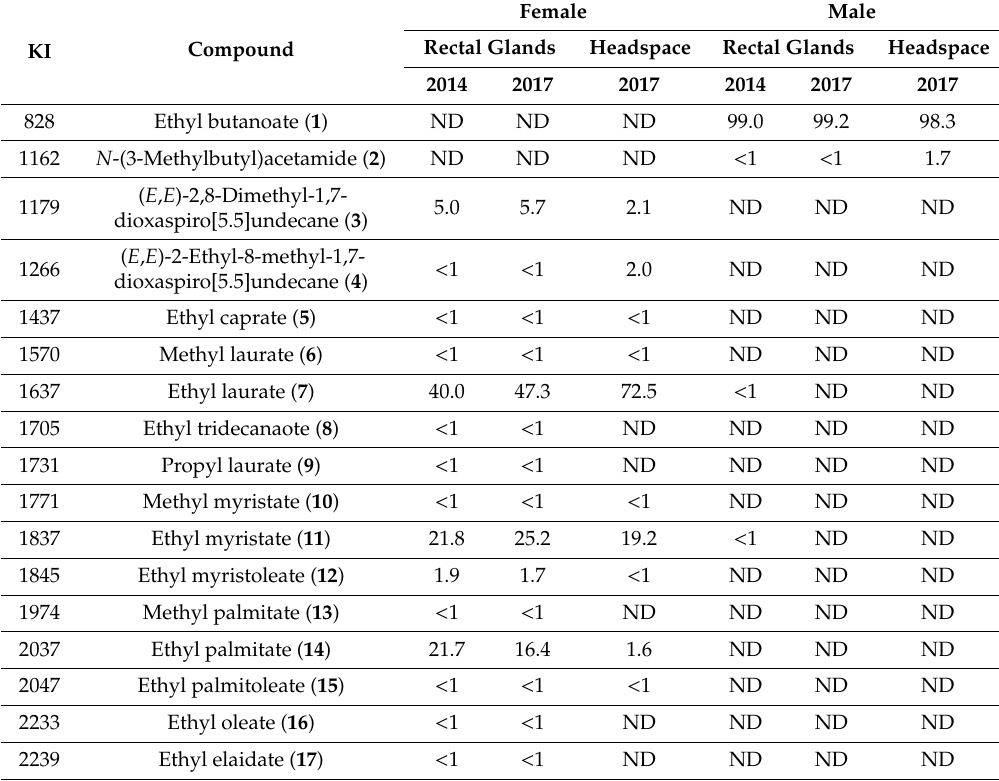
Figure 2. Typical gas chromatogram of ( A ) rectal gland extract and ( B ) headspace collections of B. musae females. Numbered peaks indicate detected compounds: ( E , E )-2,8-dimethyl-1,7-dioxaspiro[5.5]undecane ( 3 ), ( E , E )-2-ethyl-8-methyl-1,7-dioxaspiro[5.5]undecane ( 4 ), ethyl caprate ( 5 ), methyl laurate ( 6 ), ethyl laurate ( 7 ), ethyl tridecanaote ( 8 ), propyl laurate ( 9 ), methyl myristate ( 10 ), ethyl myristate ( 11 ), ethyl myristoleate ( 12 ), methyl palmitate ( 13 ), ethyl palmitate ( 14 ), ethyl palmitoleate ( 15 ), ethyl oleate ( 16 ) and ethyl elaidate ( 17 ). Table 1. Relative amount of compounds identified in chemical profiles for B. musae . KI = Kov á ts retention index, ND = not detected. Female Male Rectal Glands Headspace Rectal Glands Compound